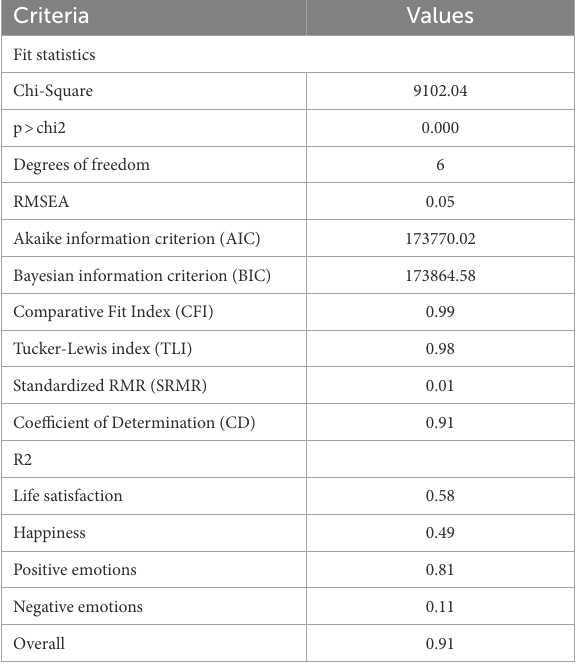
TABLE 2 CFA post-estimates, subjective well-being